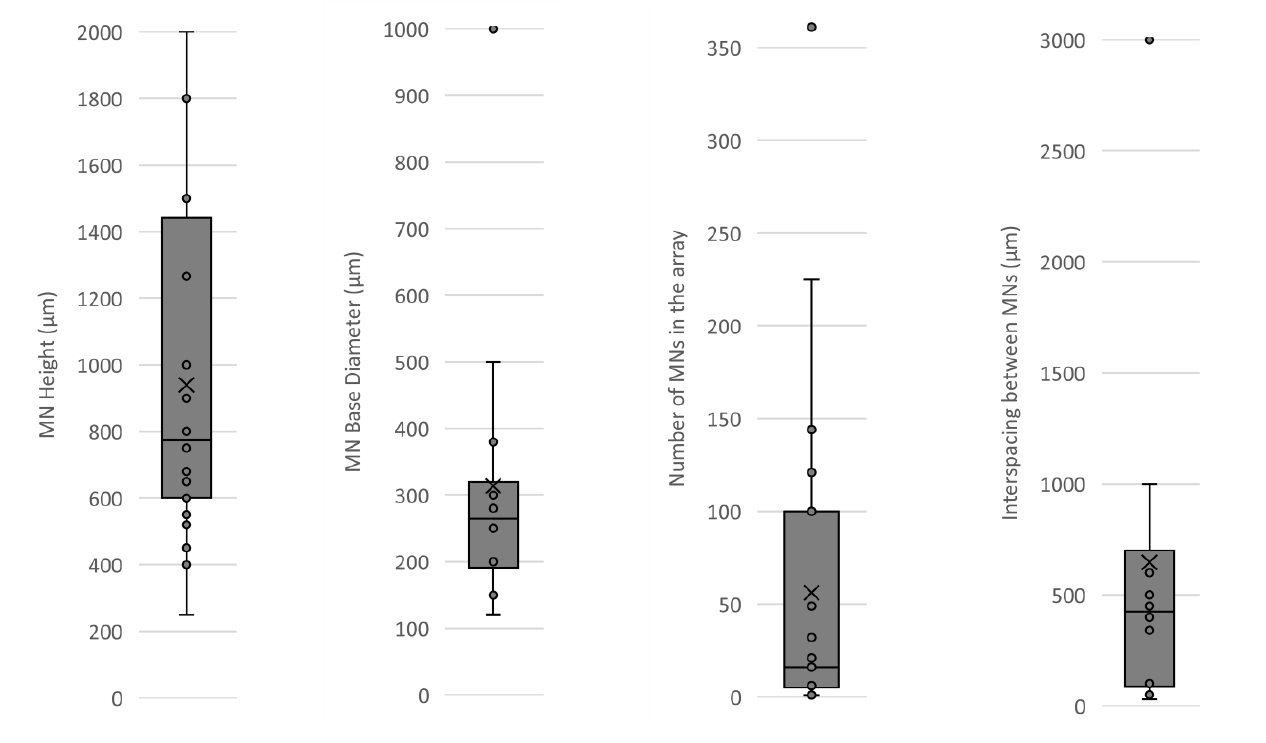
Table 2. Box charts of geometrical properties of MNAs reported in Table 1.